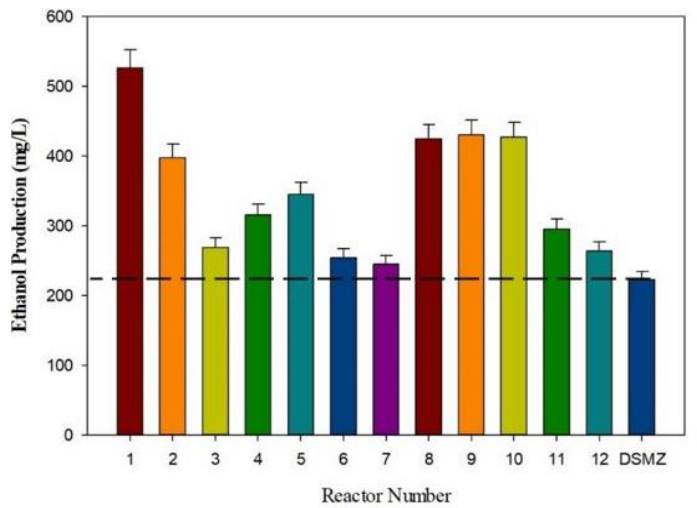
Figure 3. Ethanol production in different experimental trials.